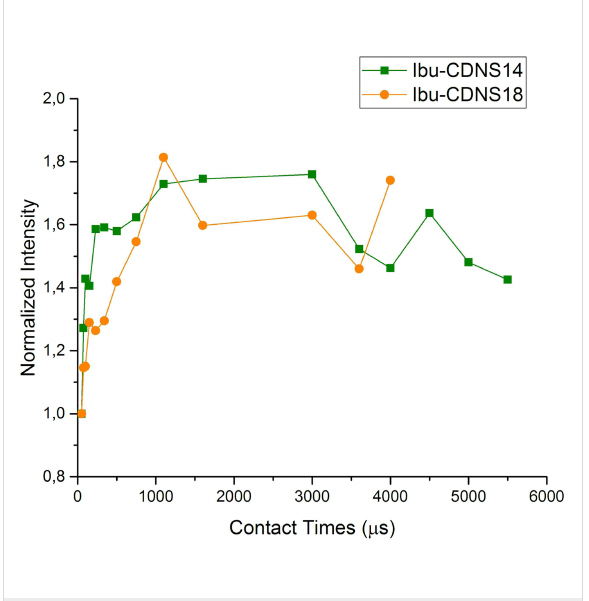
Figure 9: 1 H- 13 C CP oscillatory kinetics for the ibuprofen aromatic carbon atoms C(6,8) in samples CDNS(1:4)-IbuNa and